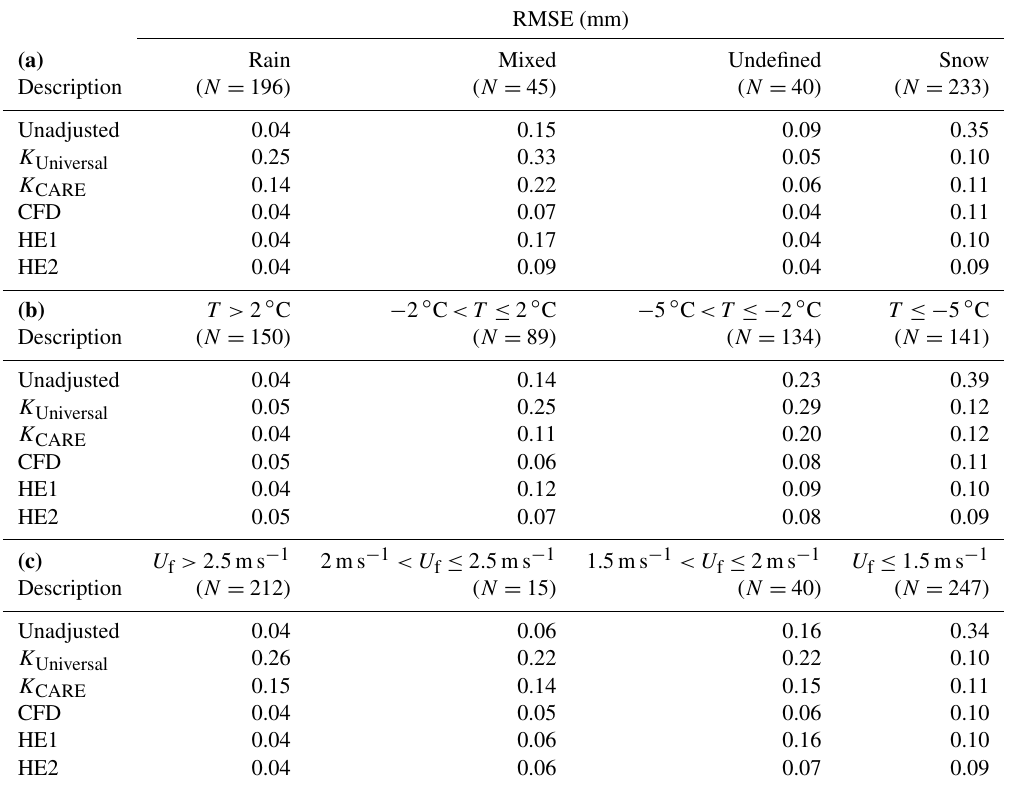
Table 5. Unshielded gauge 30min event RMSE (mm) results stratified by (a) POSS precipitation type, (b) temperature, and (c) fall velocity. Results are shown for unadjusted comparison, K Universal transfer function with wind speed and air temperature dependence, K CARE transfer function with wind speed and air temperature dependence, present study CFD transfer function with wind speed and mode fall velocity dependence, HE1 transfer function with wind speed and mean fall velocity dependence, and HE2 transfer function with wind speed and mode fall velocity dependence. Statistics are based on the comparison of experimental results from the CARE site between 1 November and 30 April 2013/14 and